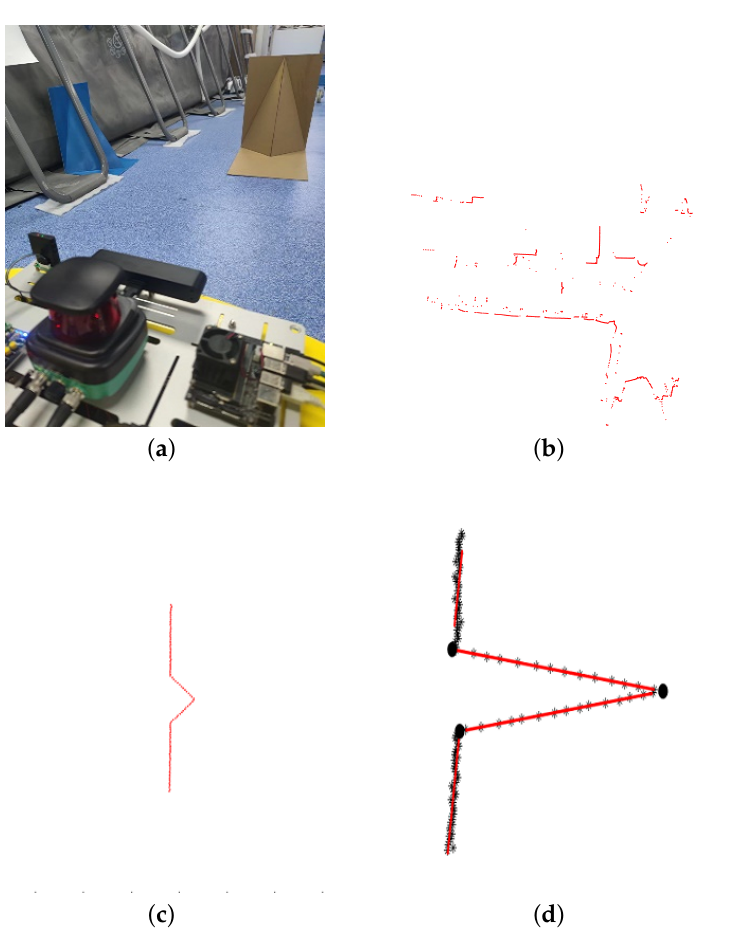
Figure 6. Features of LRF extraction and fitting. ( a ) Laser observation position. ( b ) Laser observation data. ( c ) 2D point cloud of calibration plate shape features. ( d ) Feature data of calibration plate fitting.